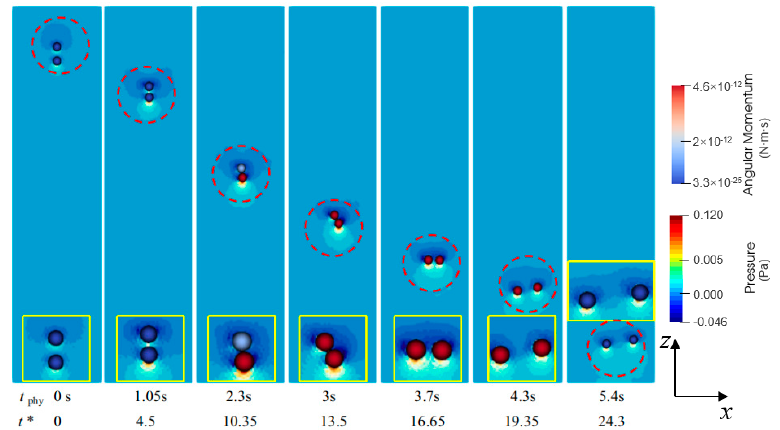
Figure 7. Distributions of pressure during settling of the two intandem particles.